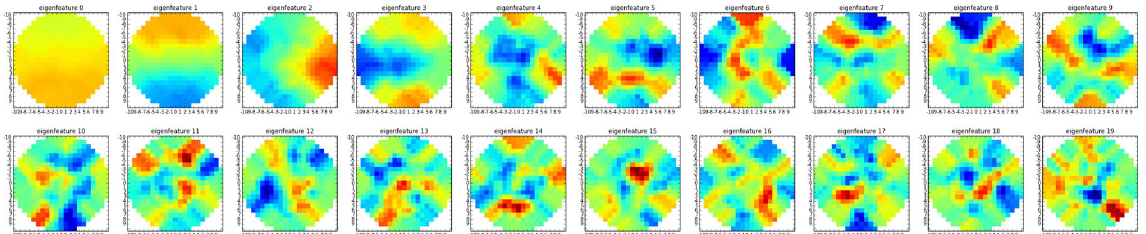
Figure 4. Masked, rotation invariant eigenvectors used as convolution kernels.